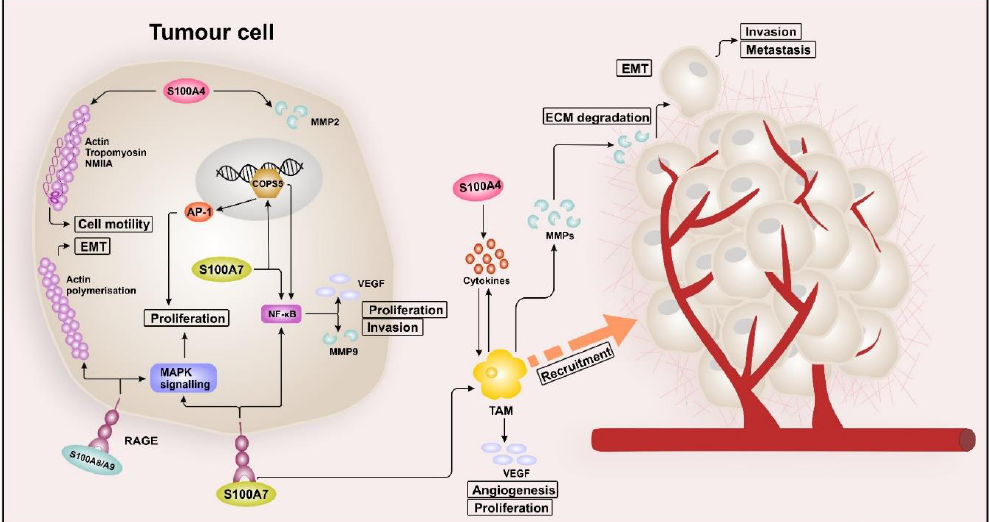
Figure 1. S100 signalling in breast cancer. Intracellular S100A4 interacts with cytoskeletal